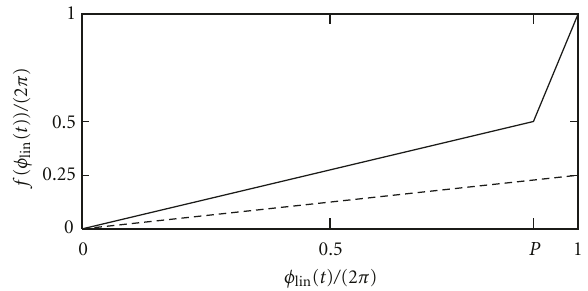
Figure 3: The phase-shaping functions of the ad-hoc model without the waveform reset modification presented in [19] (dashed line) and the phase distortion model discussed in this paper (solid